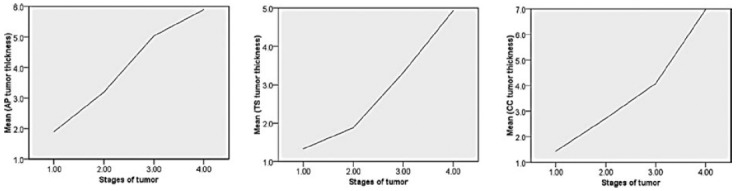
Comparison of mean tumor thickness level with stages of tumor.